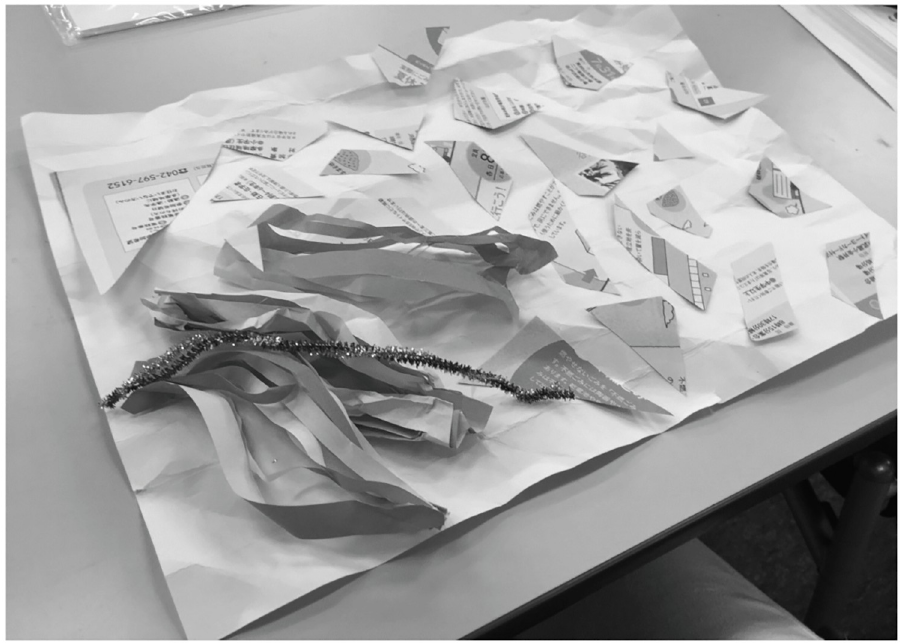
Fig 2. Sample cutout in the creative production task. The first author created this work for her preliminary experiment where she did a similar task on the theme of